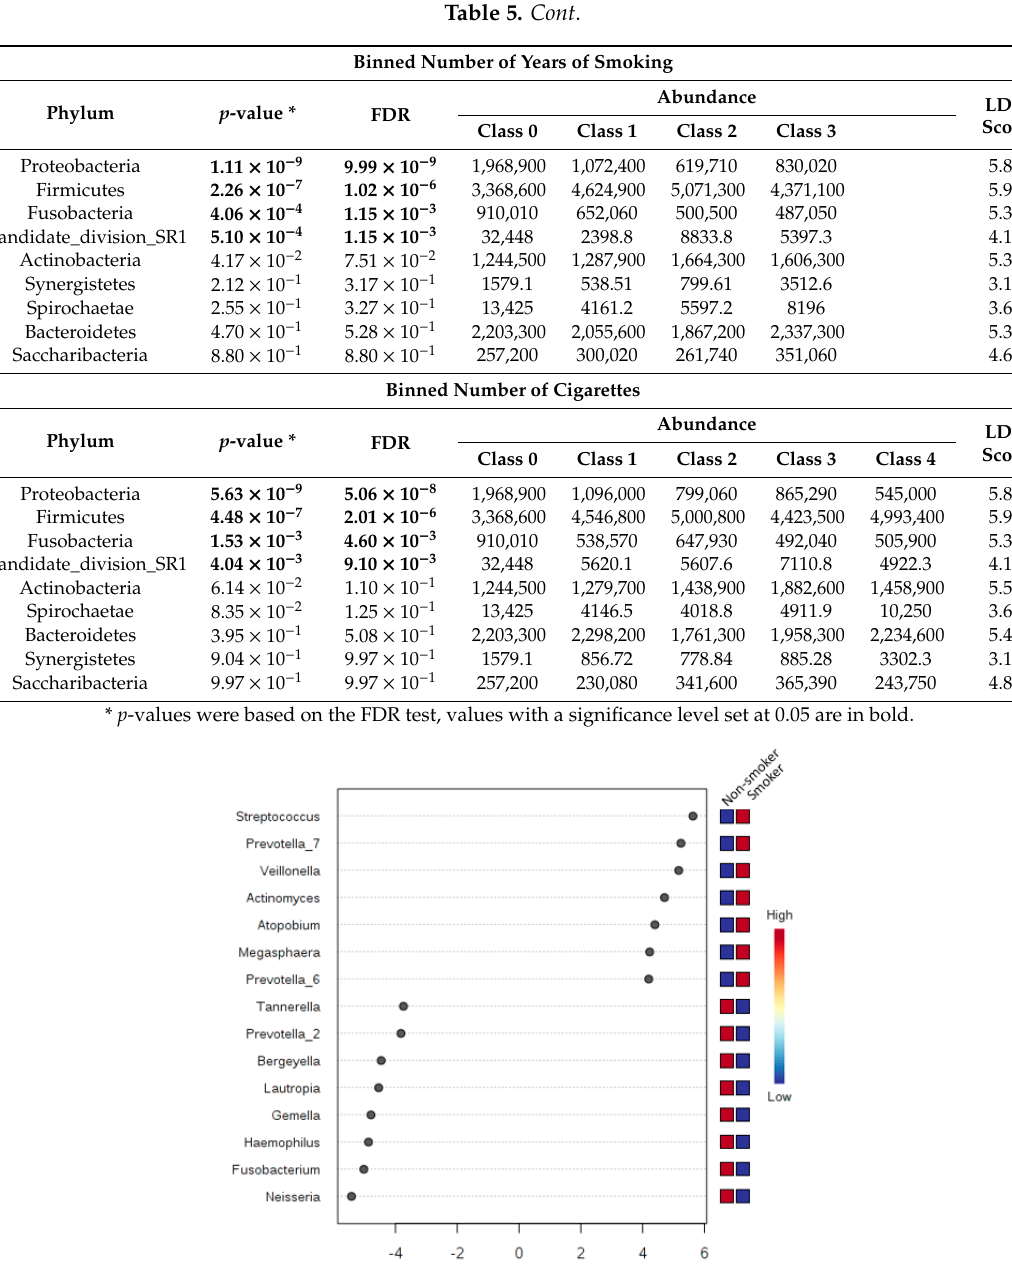
Figure 8. A plot of the LDA scores of the top 15 genera showing statistically significant differences between binned years of smoking. LDA scores on the x -axis, and genera on the y -axis. The color-coding in the squares of the right side of the plot refers to the cumulative abundance of each genus in each binned group, where red means high cumulative abundance and blue means low cumulative abundance.